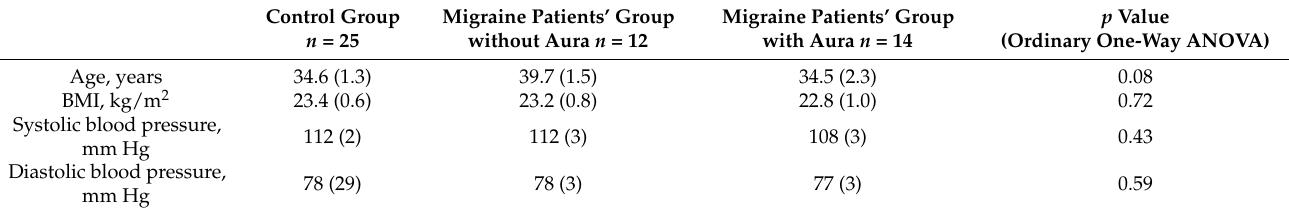
Table 1. The baseline